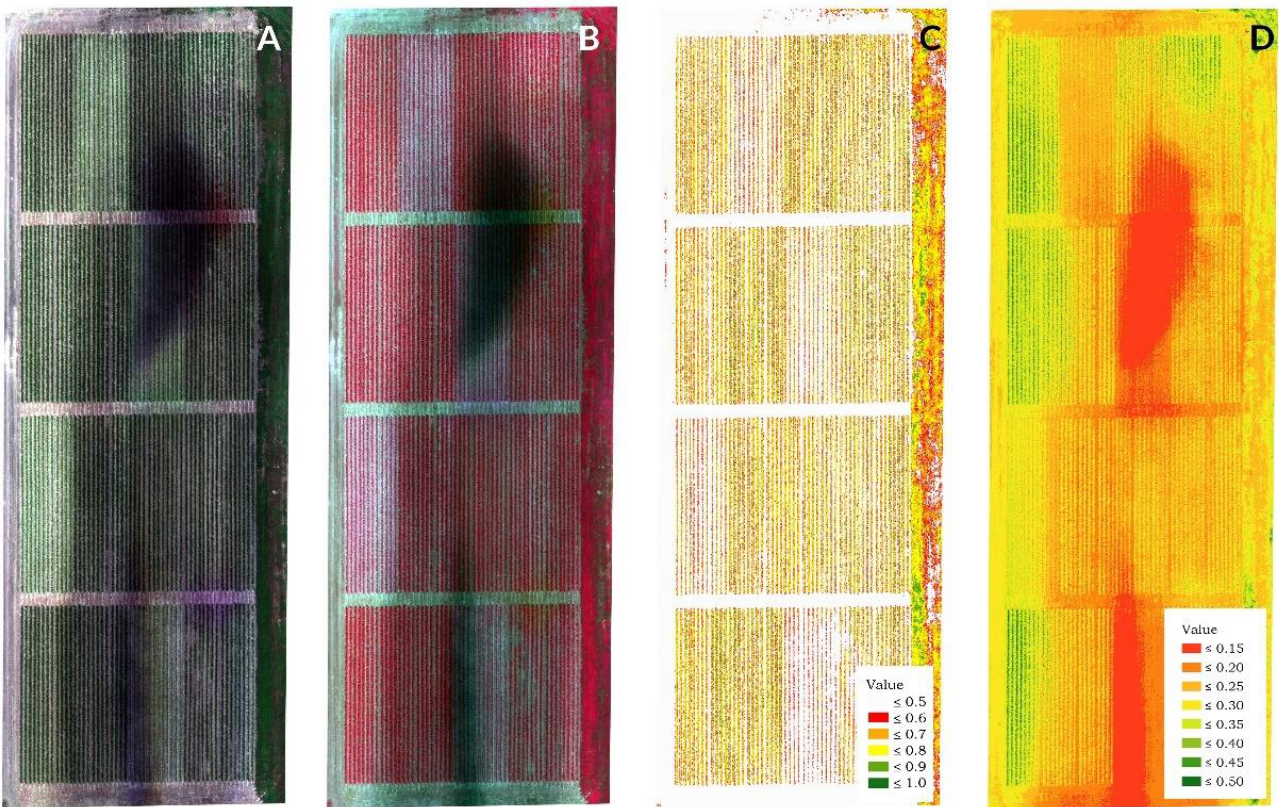
Figure 1. Effect of cloud cover on low-altitude UAS-collected five-band multispectral imagery ( A ) visible bands (blue, green, and red); ( B ) color infrared (green, red, near-infrared); ( C ) Normalized Difference Vegetation Index (green indicates more crop vigor), and ( D ) Modified Triangular Vegetation Index (green indicates more chlorophyll). The effect is clearly visible in both visible and near-infrared bands as dark pixels; hence, vegetation indices computed from these bands may be inaccurate. The severity of response varies with index but is especially pronounced in the estimation of chlorophyll shown in ( D ).